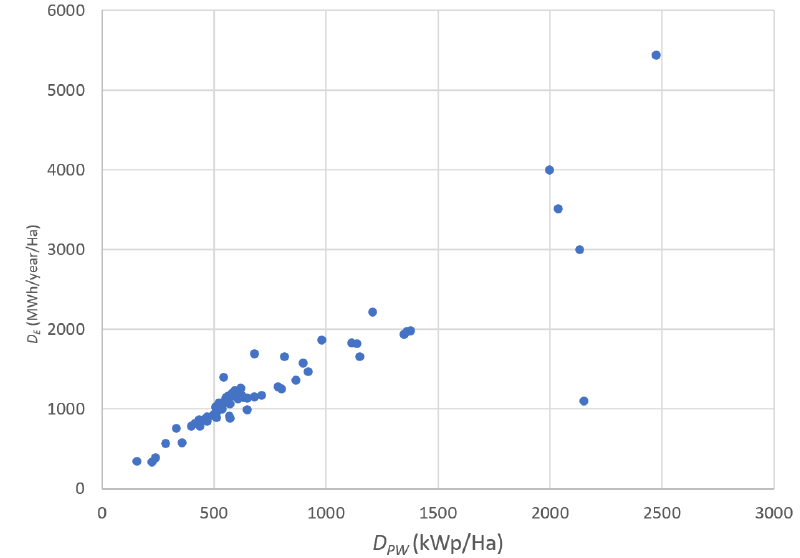
Figure 18. Graphical representation of